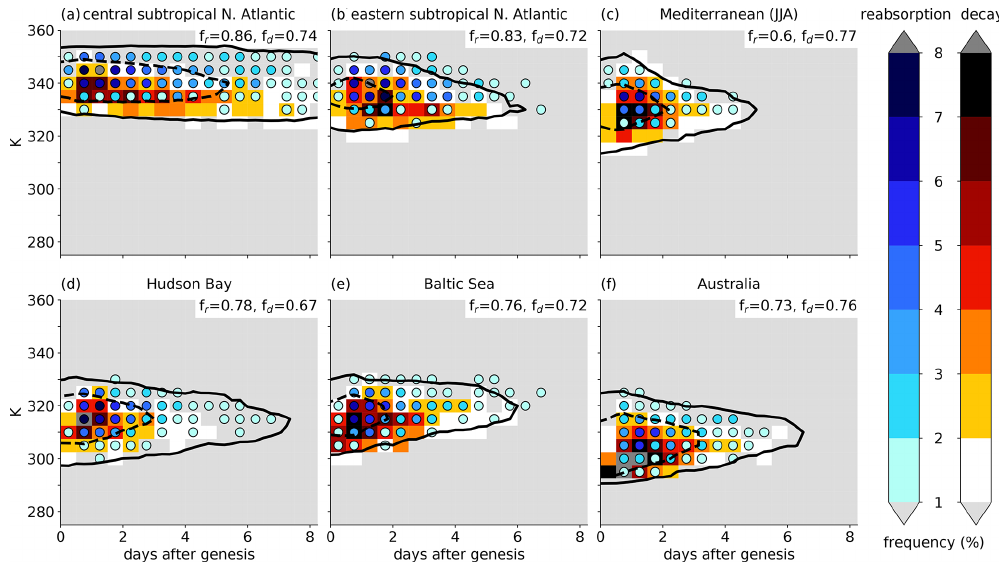
Figure 15. Same as Fig. 14 but for JJA and (a) central subtropical North Atlantic, (b) eastern subtropical North Atlantic, (c) Mediterranean, (d) Hudson Bay, (e) Baltic Sea, and (f)